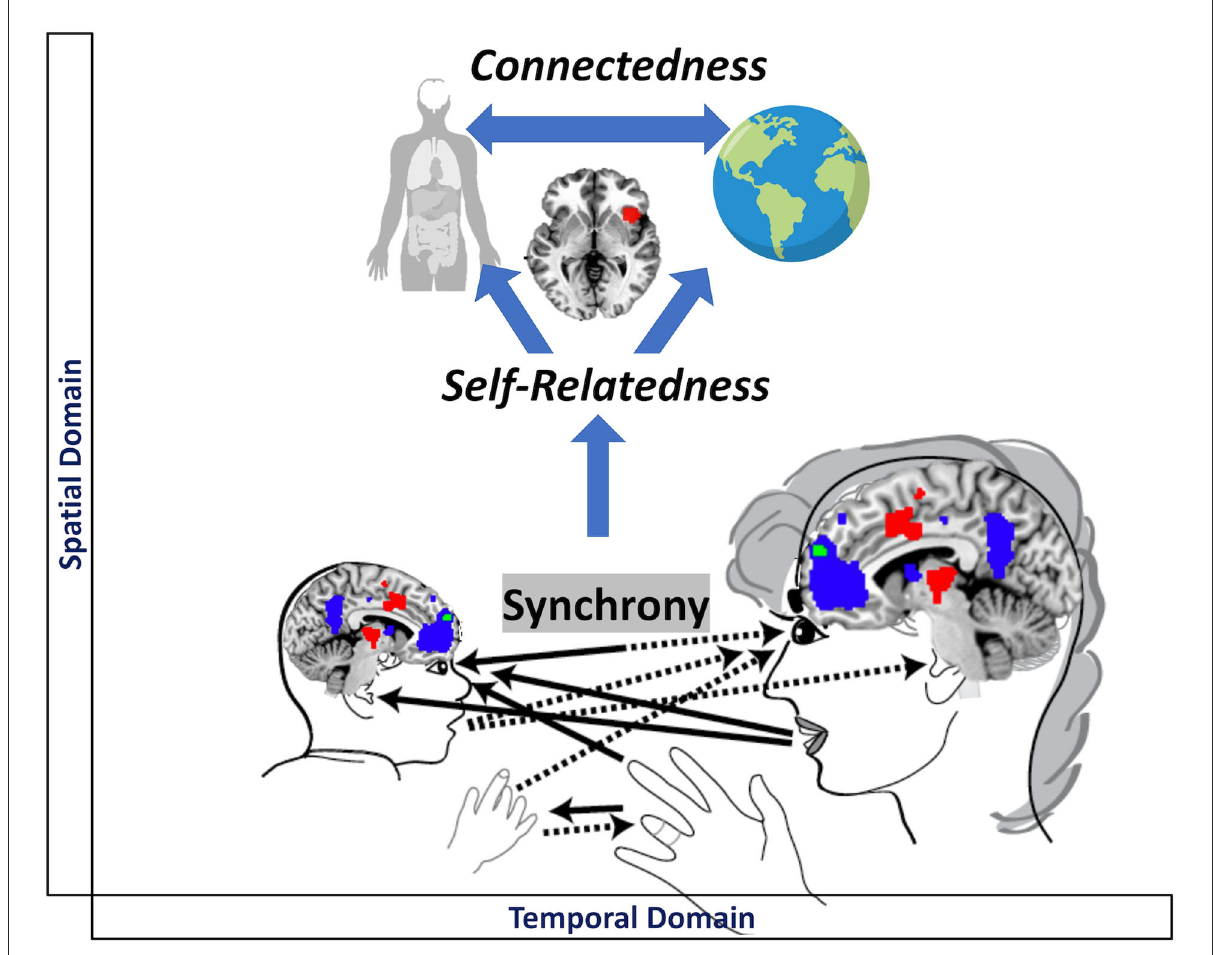
FIGURE2 Visual representation of the mutual relationship between psychological and neuronal synchronization.